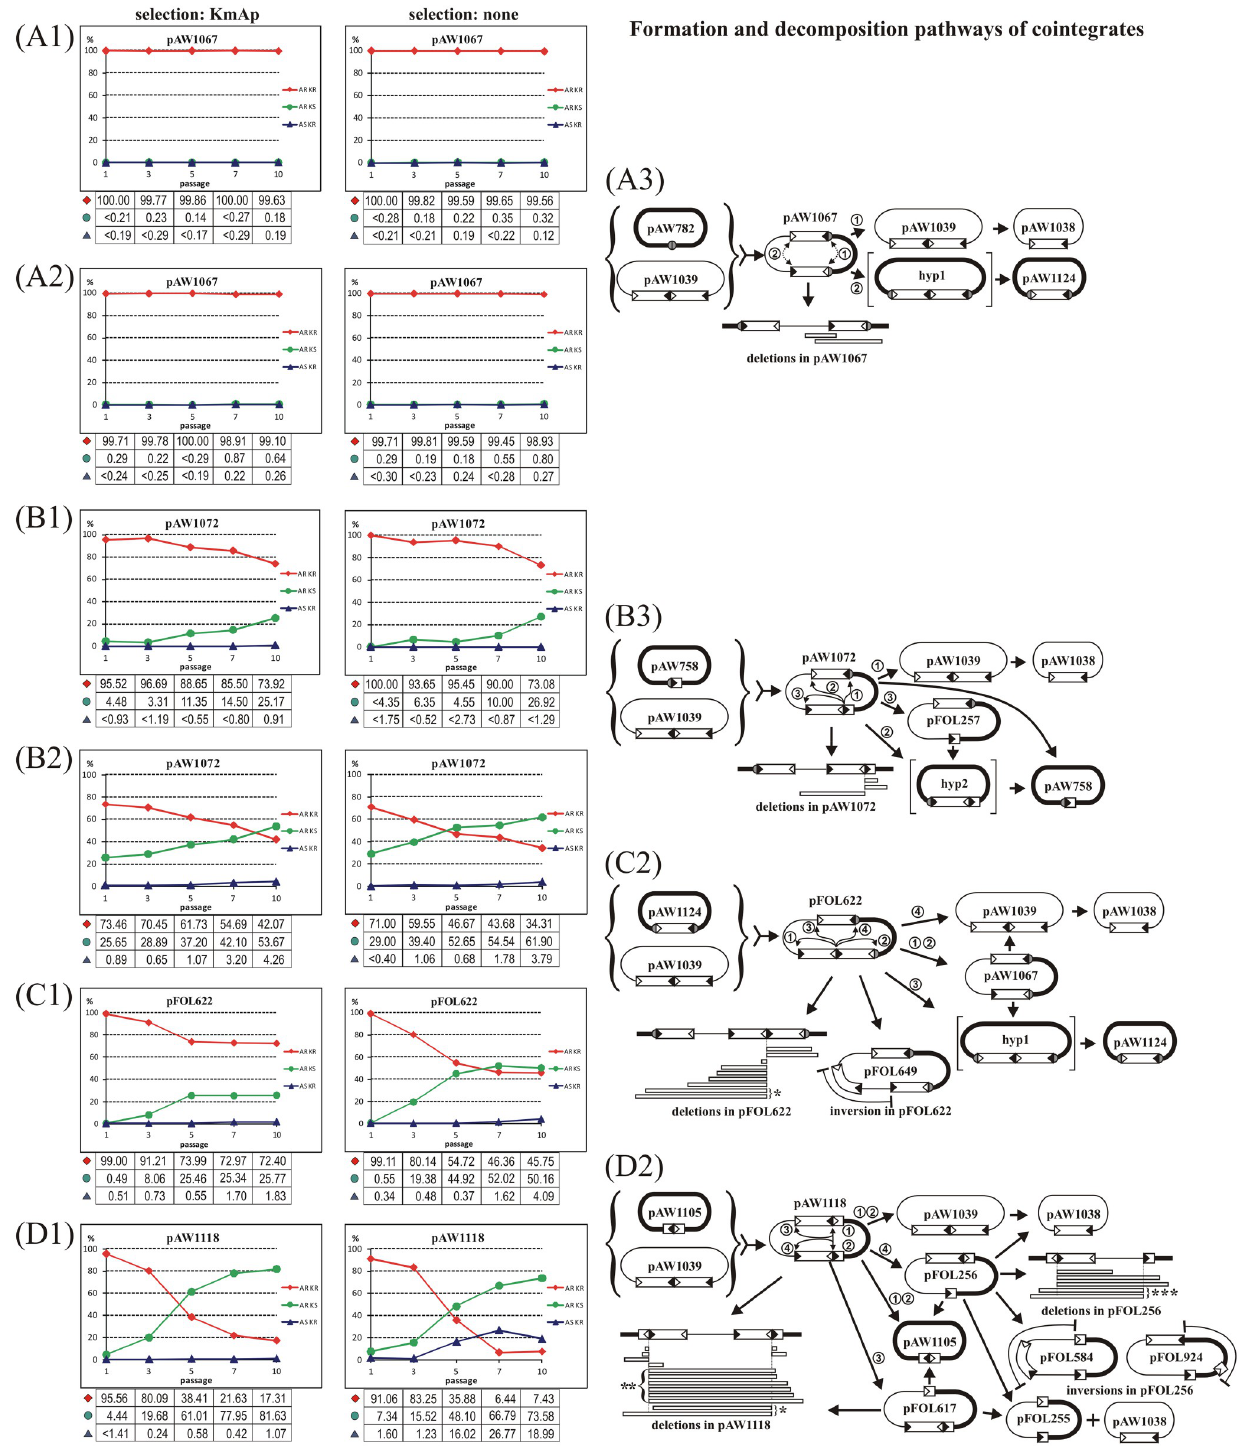
Fig 2. Dynamics and pathways of IS 30 -mediated decomposition of cointegrates. The fate of cointegrates were analysed in recA - hosts (TG2; panels A1, B1, C1, D1 and JM109; panels A2, B2) through approx. 50 generations with or without antibiotic selection for the plasmid markers. The relative frequencies of different phenotypes are shown on the graphs and the percent values are given underneath. The three phenotypes are marked as AR KR, AR KS and AS KR (Ap R Km R , Ap R Km S and Ap S Km R , respectively). Panels A3, B3, C2 and D2 summarize the formation (the parental plasmids of the cointegrates are in curly brackets) and the main decomposition paths of the cointegrates observed in the different hosts and growth conditions. Thin line—